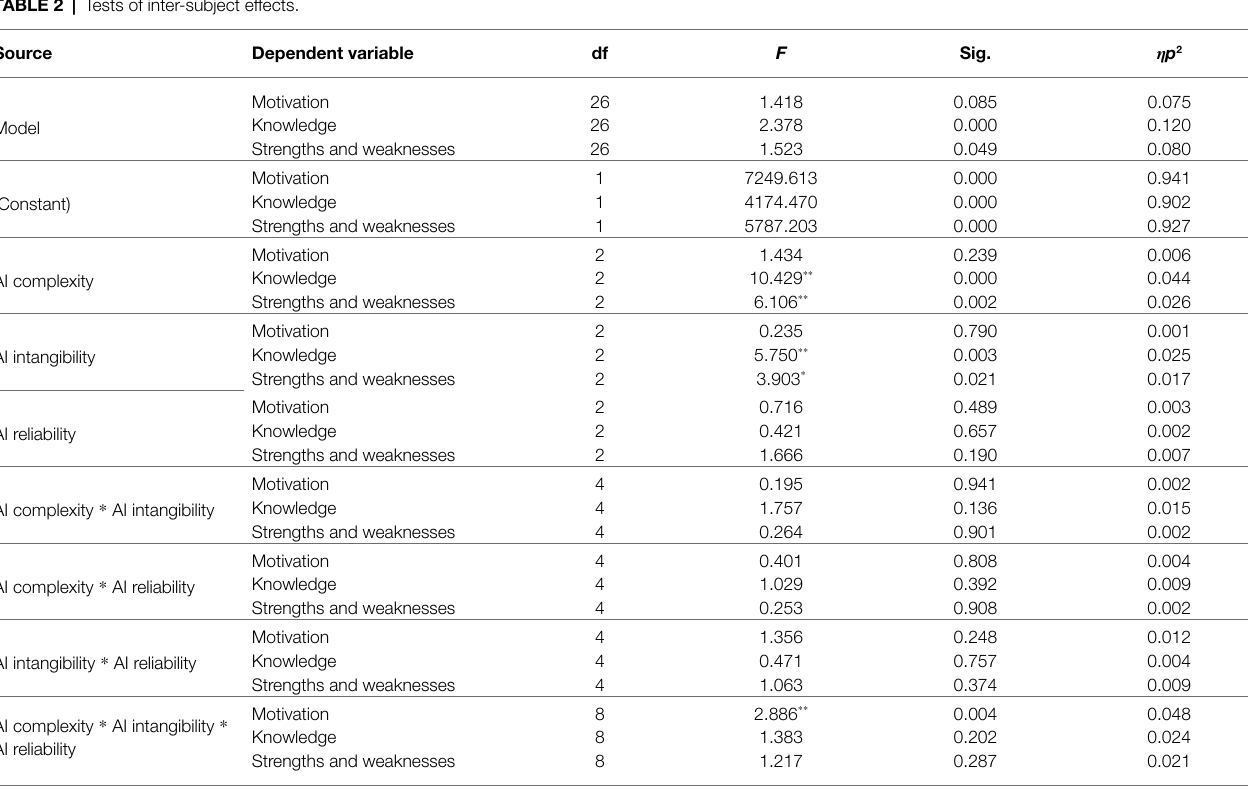
TABLE 2 | Tests of inter-subject